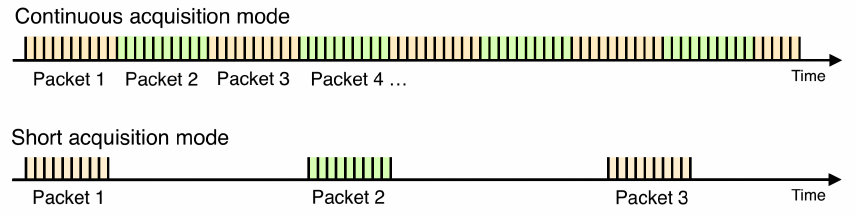
Figure 3. Data packets for ContinuousAcqMode and